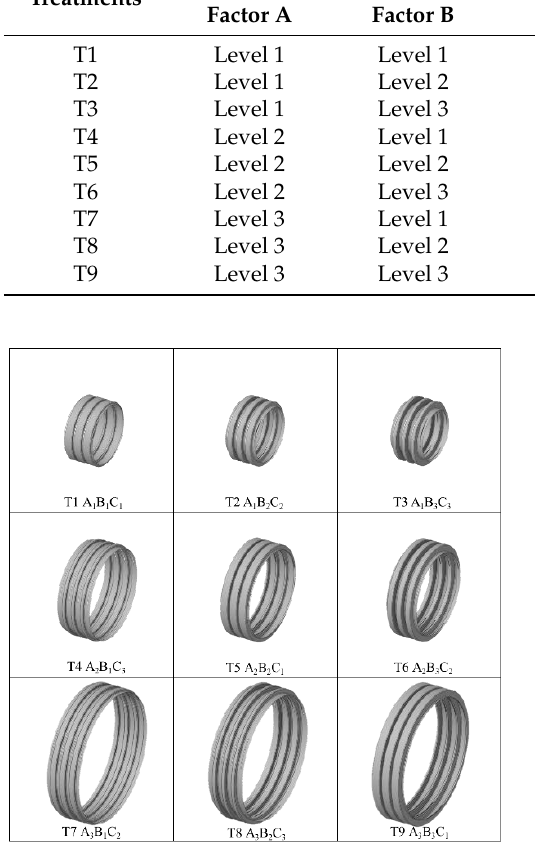
Figure 8. Corrugated pipe numerical model of the orthogonal test. (A: outer diameter; B: groove depth; C: groove width).